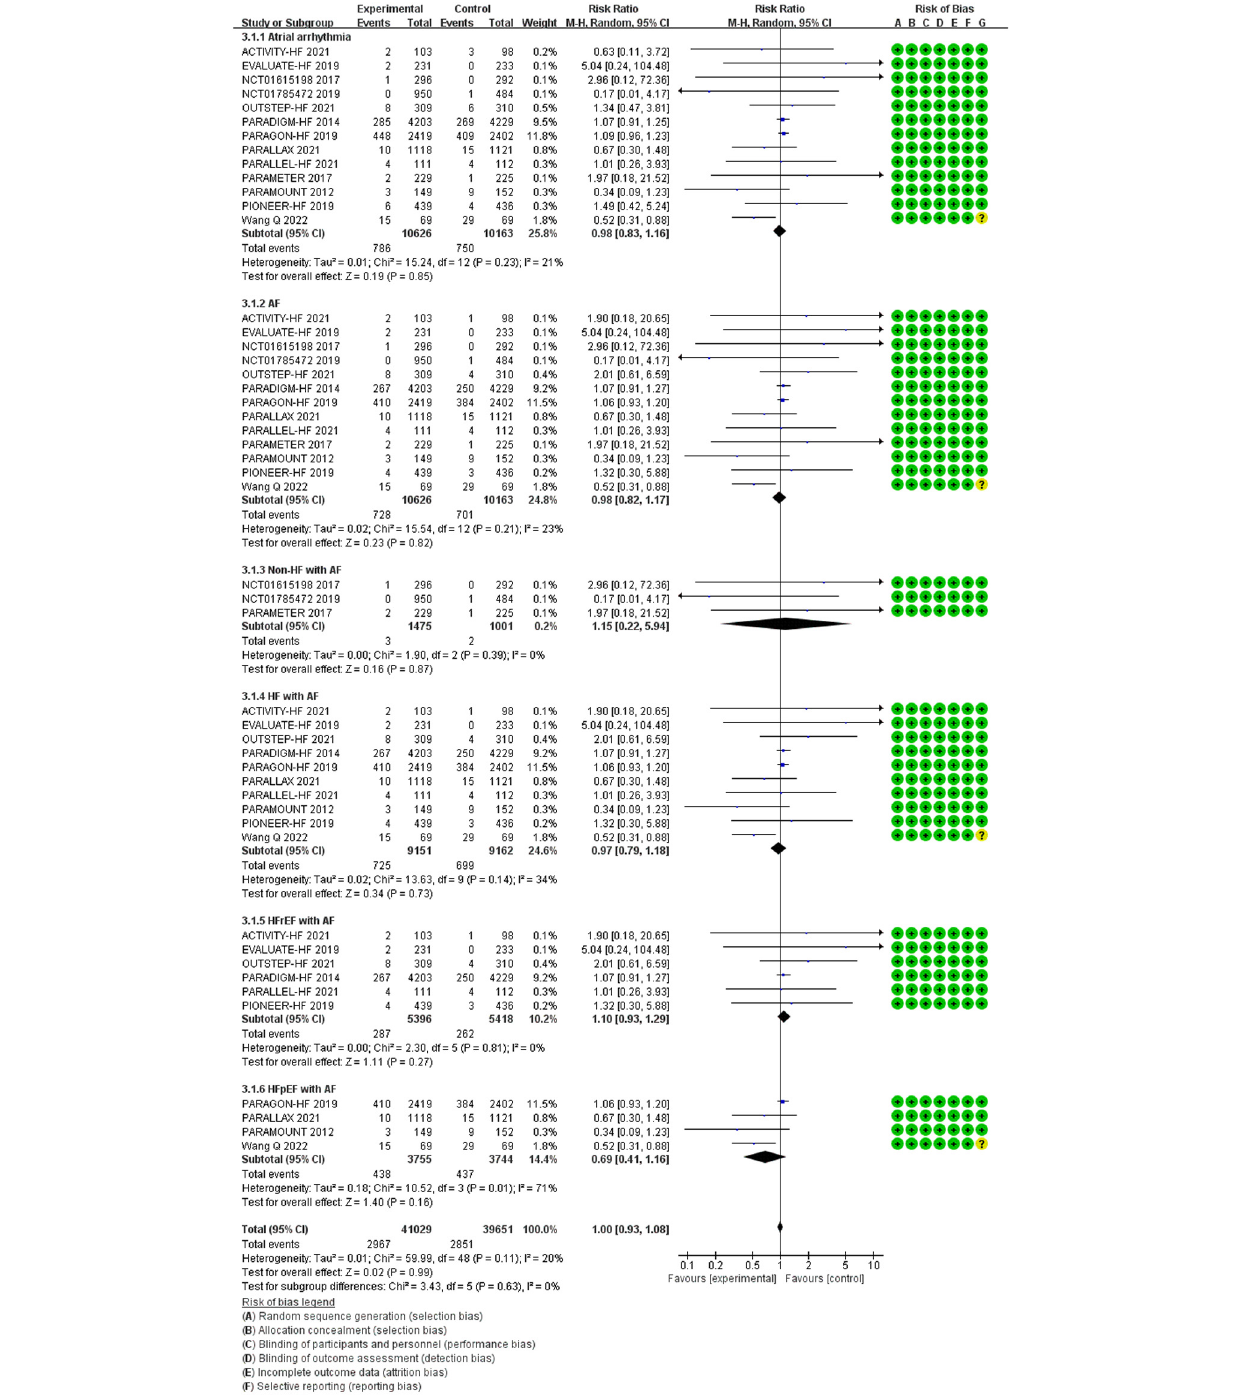
vasoconstriction problem caused by the increased concentration of angiotensin II caused by NEPI, the combined use of valsartan can enhance the inhibition of vasoconstriction, cardiomyocyte